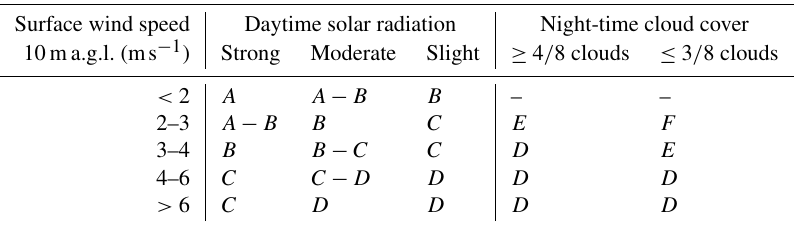
Table 3. Atmospheric stability classification scheme based on surface wind speed and solar insulation for daytime conditions and cloud cover during night-time conditions (Pasquill, 1968), ranging from very unstable ( A ) to moderately stable ( E ).